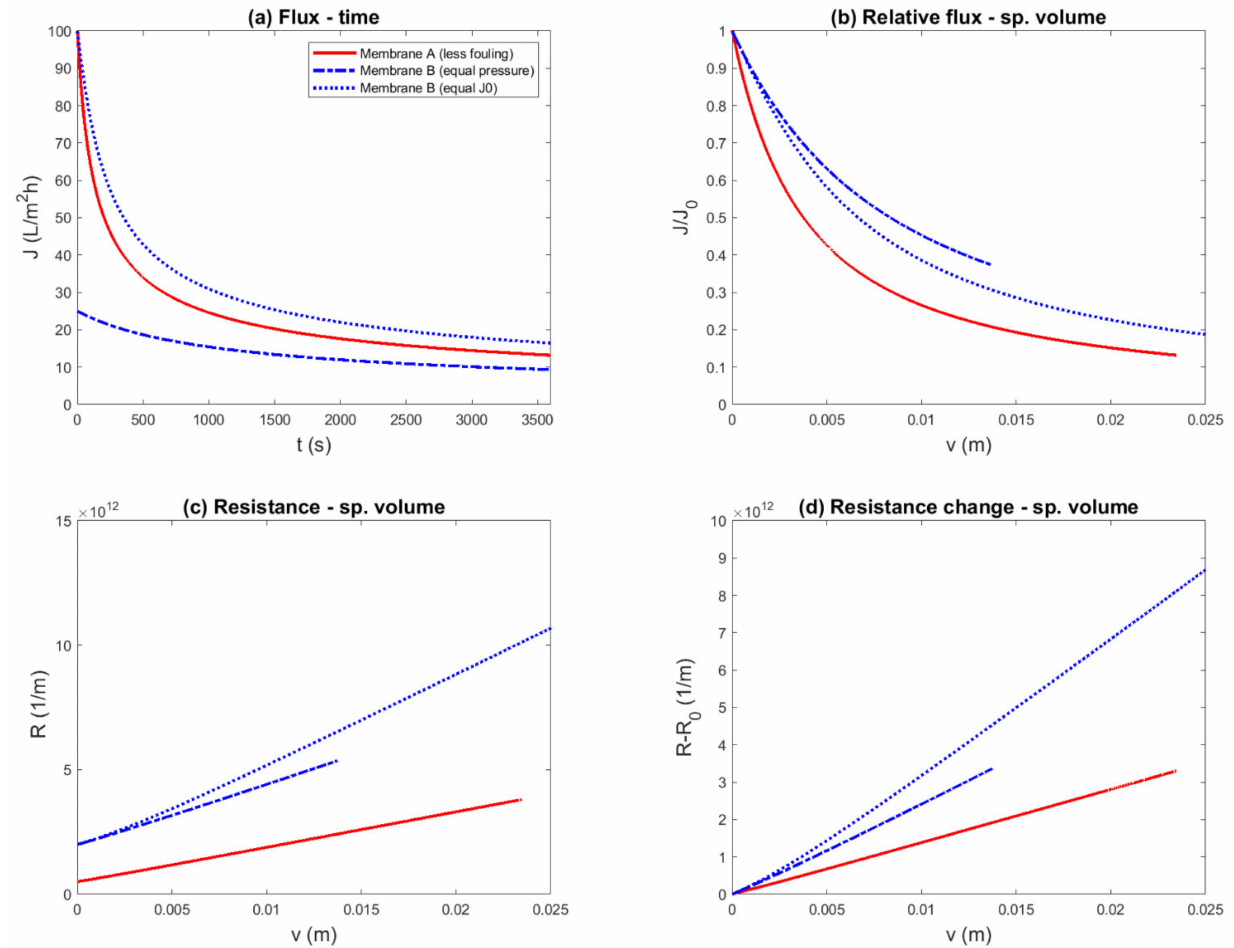
Figure 5. Simulated constant-pressure experiment, aiming to compare two membranes with equal transmembrane pressure (0.39 bar) or equal initial flux (TMP A = 0.39 bar, TMP B = 0.81 bar). The example was constructed such that membrane A was superior to membrane B, due to a lower membrane resistance ( R MA = 0.5 × 10 12 m − 1 vs. R MB = 2.0 × 10 12 m − 1 ), a lower fouling rate ( α A = 3.0 × 10 13 m − 2 vs. α B = 6.0 × 10 13 m − 2 ), and a lower structural parameter ( s A = 3.75 × 10 − 4 vs. s B = 7.5 × 10 − 4 ( r = 10 nm ) and D = 1 × 10 − 10 m 2 /s, Π F = 0.25 bar ). Different representations ( a —Flux–Time; b